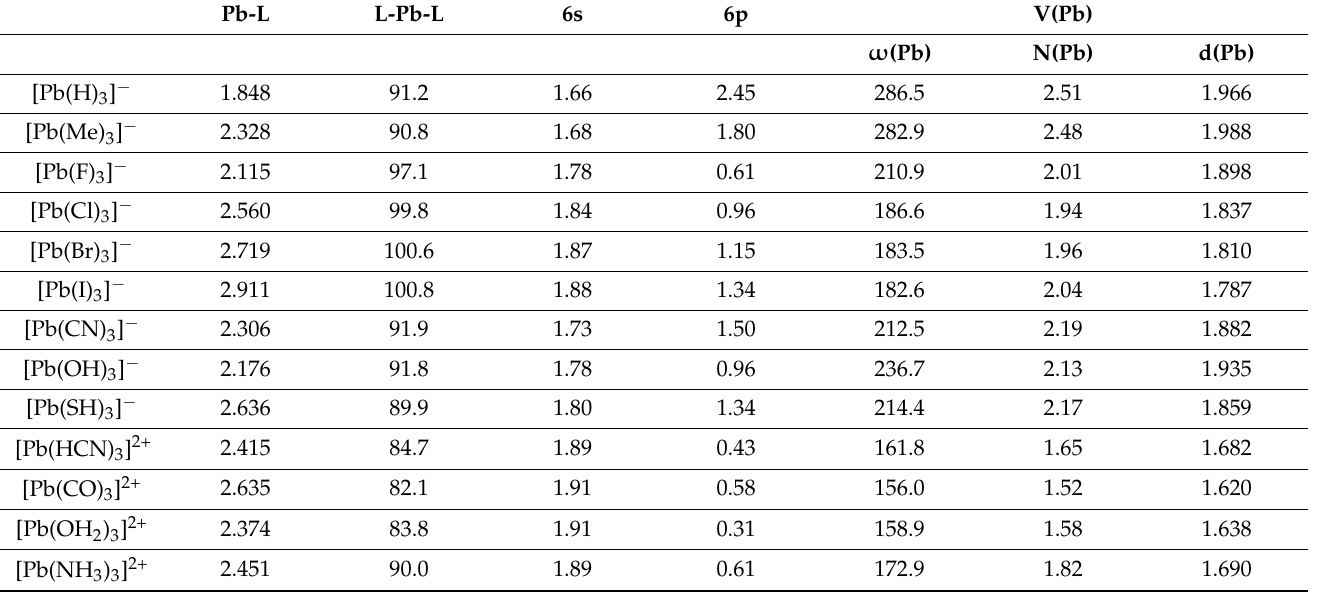
Table 3. Properties of [Pb(L) 3 ] q complexes. Pb-L bond length in Angstroms. L-Pb-L angle in degrees. Electronic population of the 6s and 6p shells of lead from NBO analysis. Volume ( ω (Pb) in Å 3 ), population (N(Pb) in electrons) of lead valence basin and distance (d(Pb) in Å) of the V(Pb) ELF attractor and